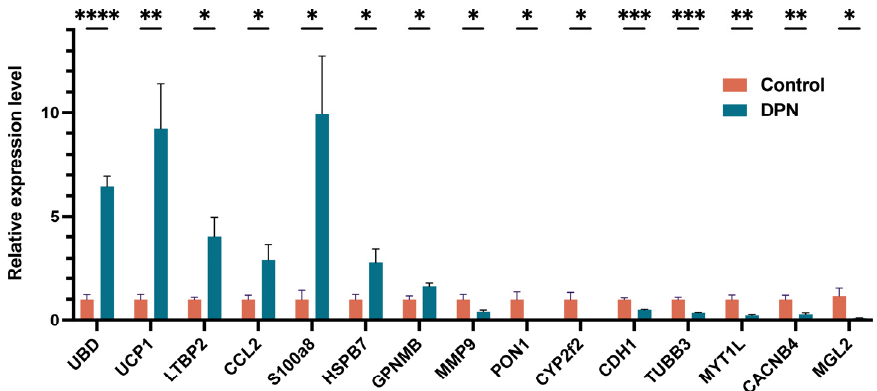
Figure 8. Confirmation of microarray data in sciatic nerves from db/db diabetic mice and db/+ nondiabetic mice by qRT-PCR. The microarray data and qRT-PCR results are consistent. Results were presented as means ± SEM of five independent experiments (* p < 0.05, ** p < 0.01, *** p < 0.001, **** p < 0.0001).